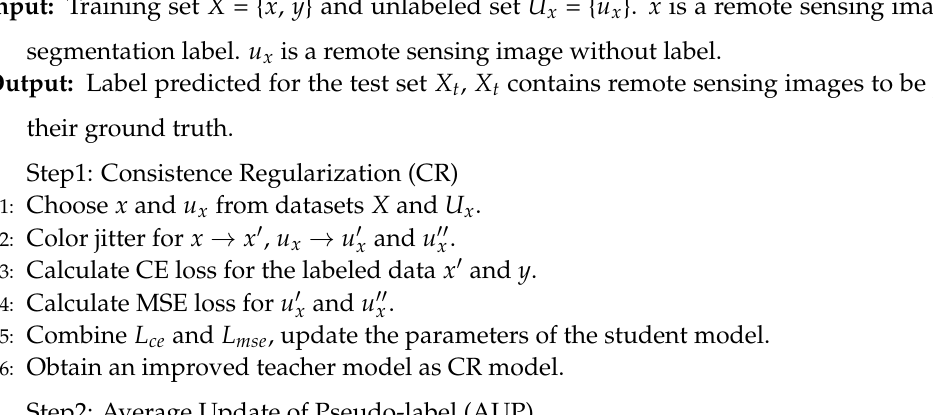
Algorithm 1 Semi-supervised remote sensing image semantic segmentation by CR and AUP